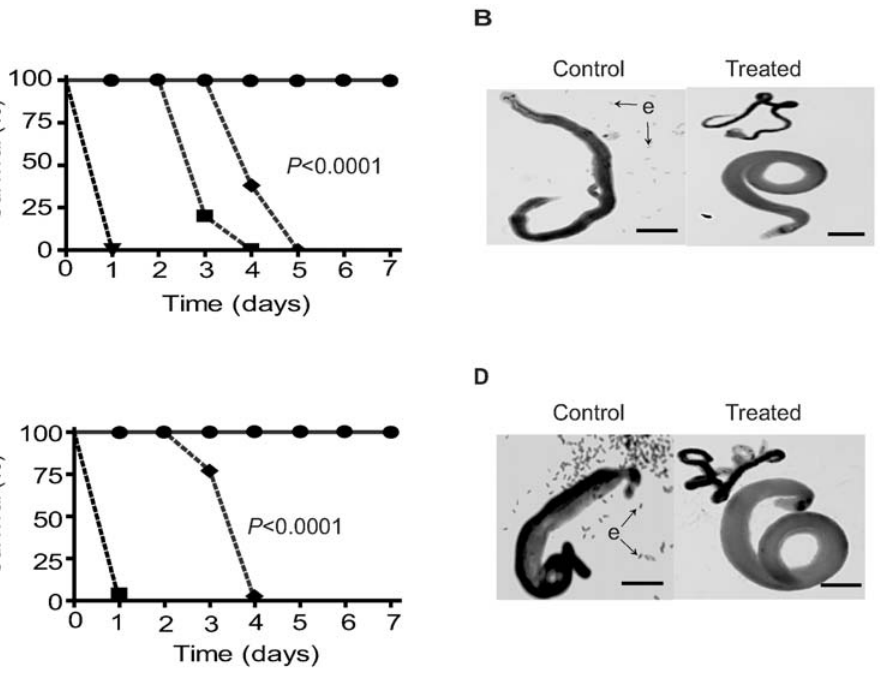
Figure 3. PKA activity is essential for adult S.mansoni viability invitro . Adult S. mansoni worm pairs were maintained in medium containing N varying concentrations of H-89 (A and B) or PKI 14–22 amide (C and D). Survival in the presence of each inhibitor was plotted against time (A and C). N ); 10 m M ( ¤ ); 25 m M ( & ); 50, 100, 250, and 500 m M ( . ). For PKI 14–22 amide For H-89, concentrations of inhibitor are as follows: 0 and 1 m M ( ); 100 m M ( ¤ ); 250 and 500 m M ( & ). Treatment groups containing 6 worm pairs concentrations of inhibitor are as follows: 0, 1, 10, 25, and 50 m M ( each (12 worms total) were used for each concentration. B and D, micrographs of representative worm pairs incubated in the presence of 100 m M H- 89 (B) or100 m M PKI 14–22 amide (D). Scale bars=1 mm. e, parasite eggs. Data are representative of three independent